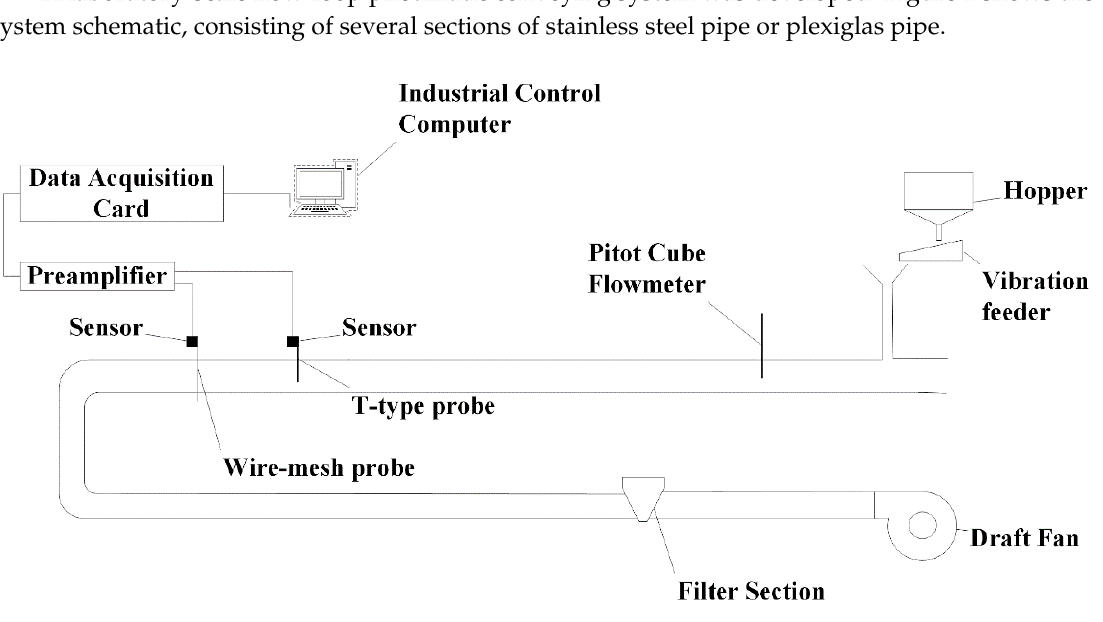
Figure 1. The schematic for the pneumatic conveying system.